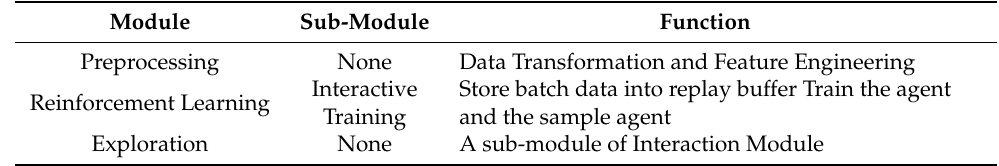
Table 5. Intrusion Detection Framework at Flow-level.